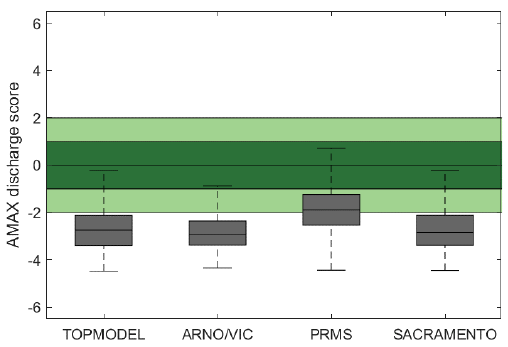
Figure 11. Predictive capability of four hydrological models for annual maximum (AMAX) flows across Great Britain. Shown is behavioural model ensemble (NSE > 0.5) median performance in replicating the observed AMAX flows, with a value of 0 being a perfect score and a value of 1 meaning that the simulated AMAX value was at the limits of the observational uncertainty. The spread covers all catchments.